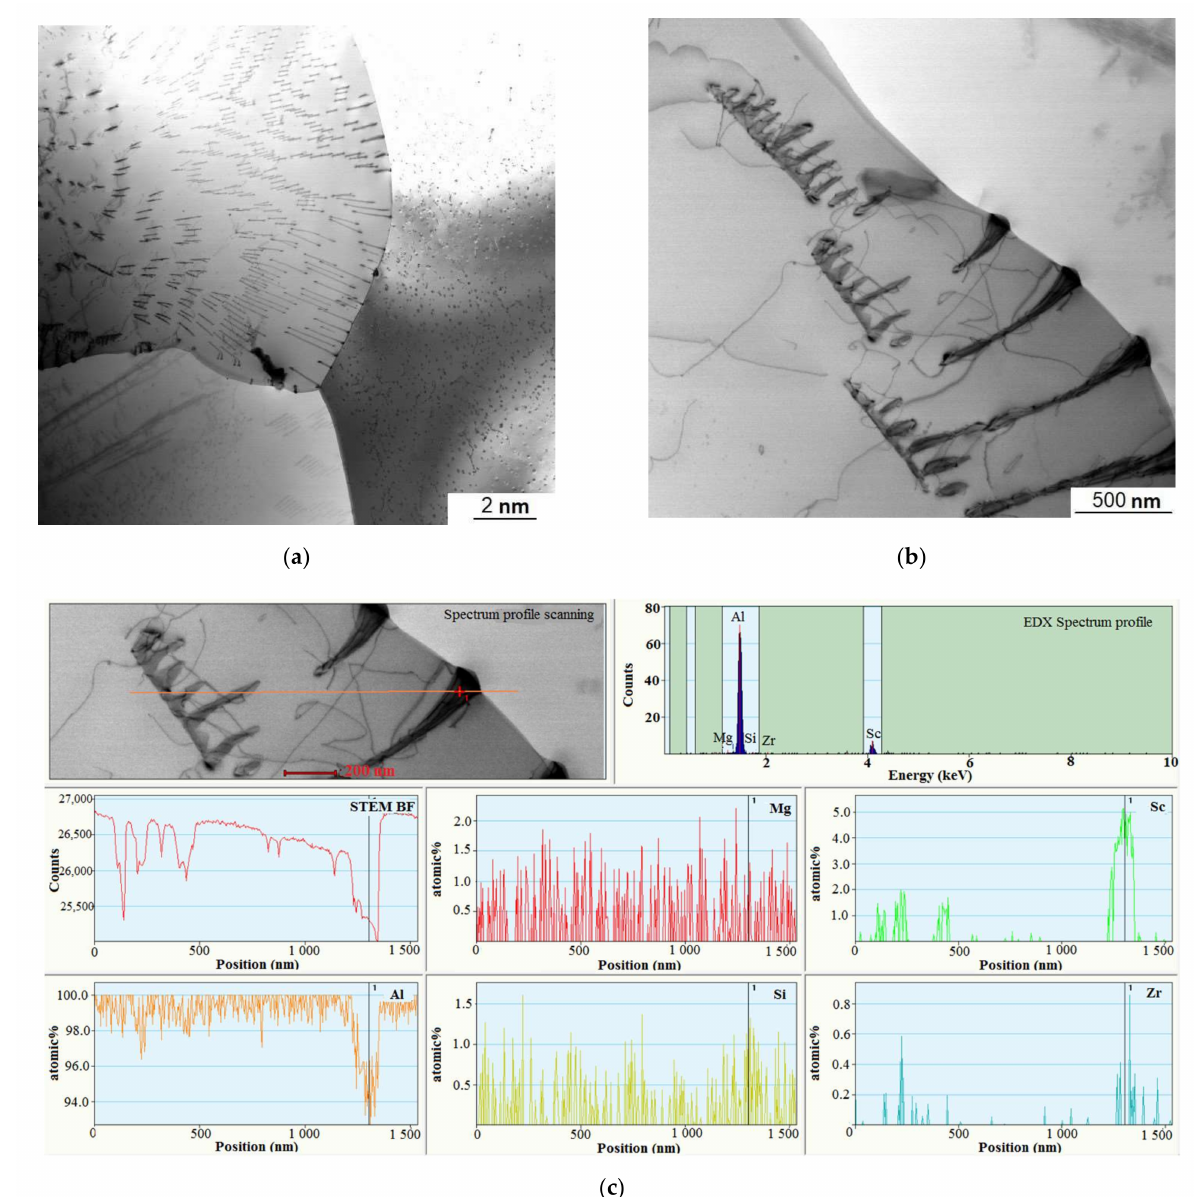
Figure 9. Al 0.3 Mg1Si 0.15 Zr 0.3 S steel chill mold ( a ); ( b ) Particles (AlSi) 3 ScZr and Al 3 Sc; ( c ) EDS profile line